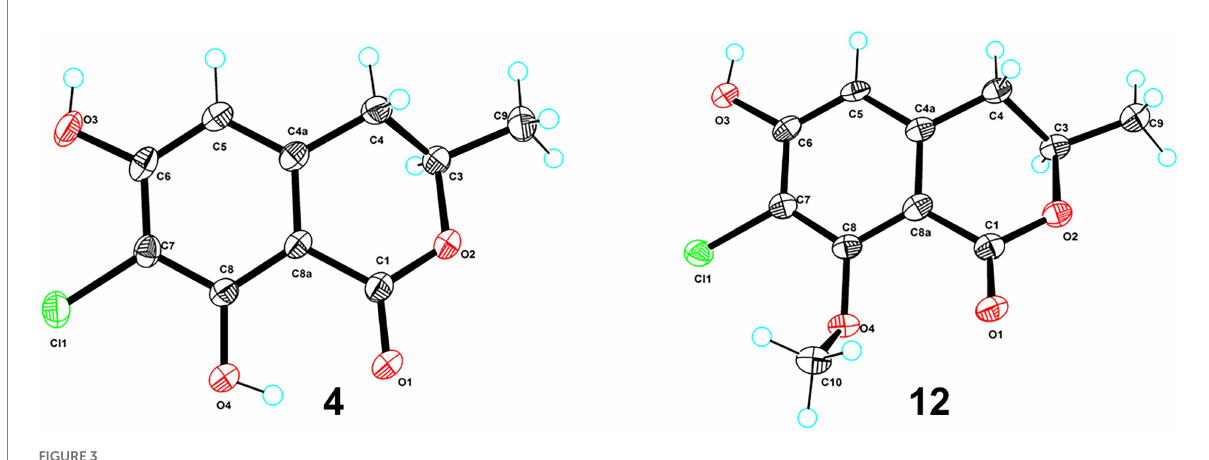
FIGURE 3 ORTEP diagrams of compounds 4 and 12